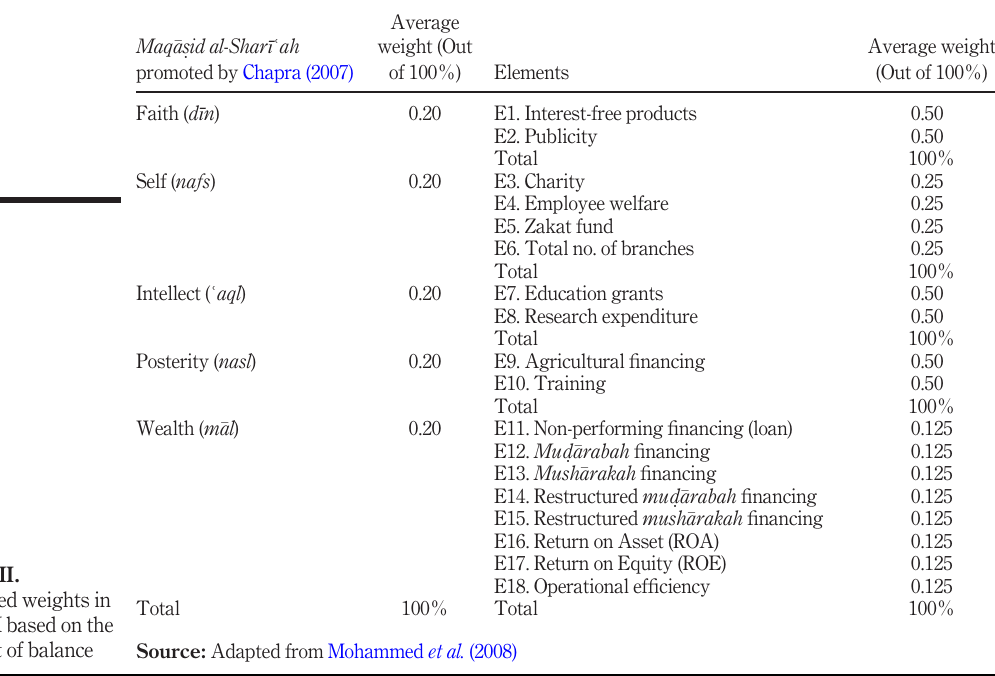
Table II. Assigned weights in IMSPM based on the concept of